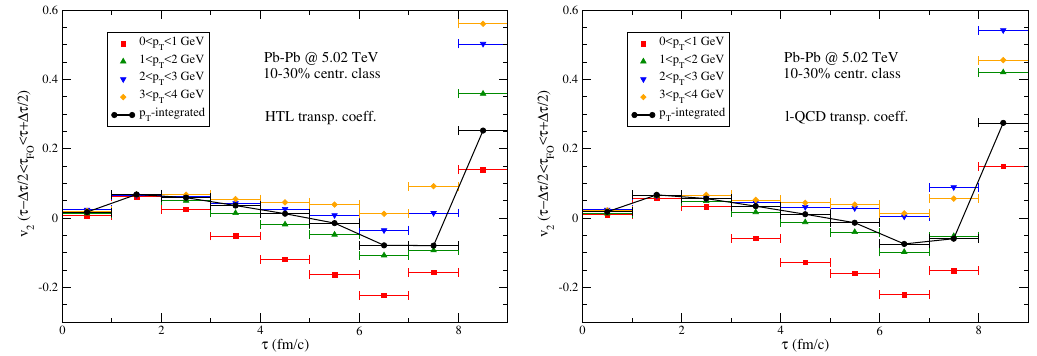
Figure 6 . The elliptic (cid:13)ow of charm quarks decoupling at various values of the longitudinal proper-time (cid:28) in 10-30% semi-central Pb-Pb collisions for di(cid:11)erent p T -bins with HTL (left panel) and l-QCD (right panel) transport coe(cid:14)cients. Di(cid:11)erences arise at late time and for the hardest particles, due to the di(cid:11)erent momentum-dependence of the transport coe(cid:14)cients.